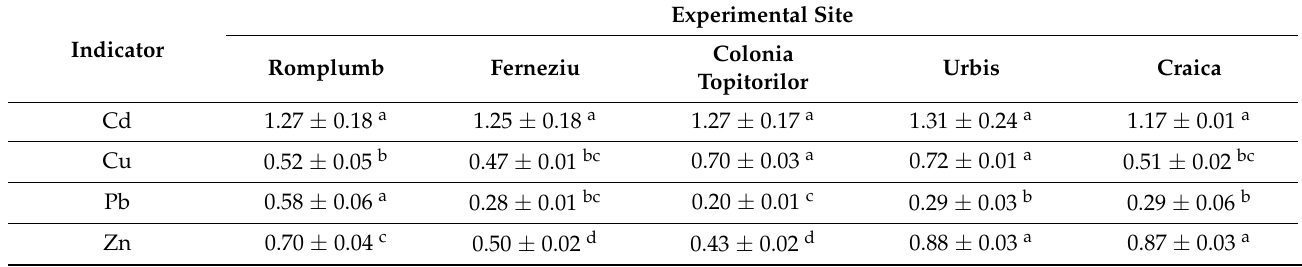
Table 4. The potential of RJ in accumulating HM (Cd, Cu, Pb and Zn) according to the TF.